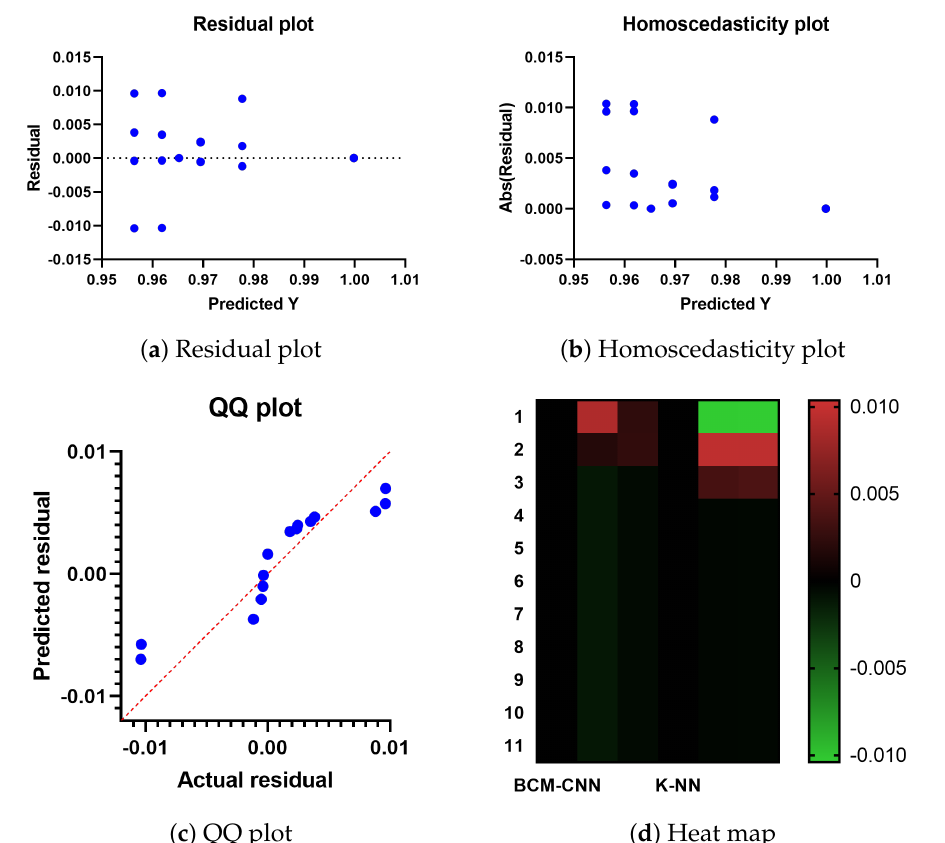
Figure 7. The heat map, residual, QQ, and homoscedasticity plots of the ADSCFGWO and compara- ble